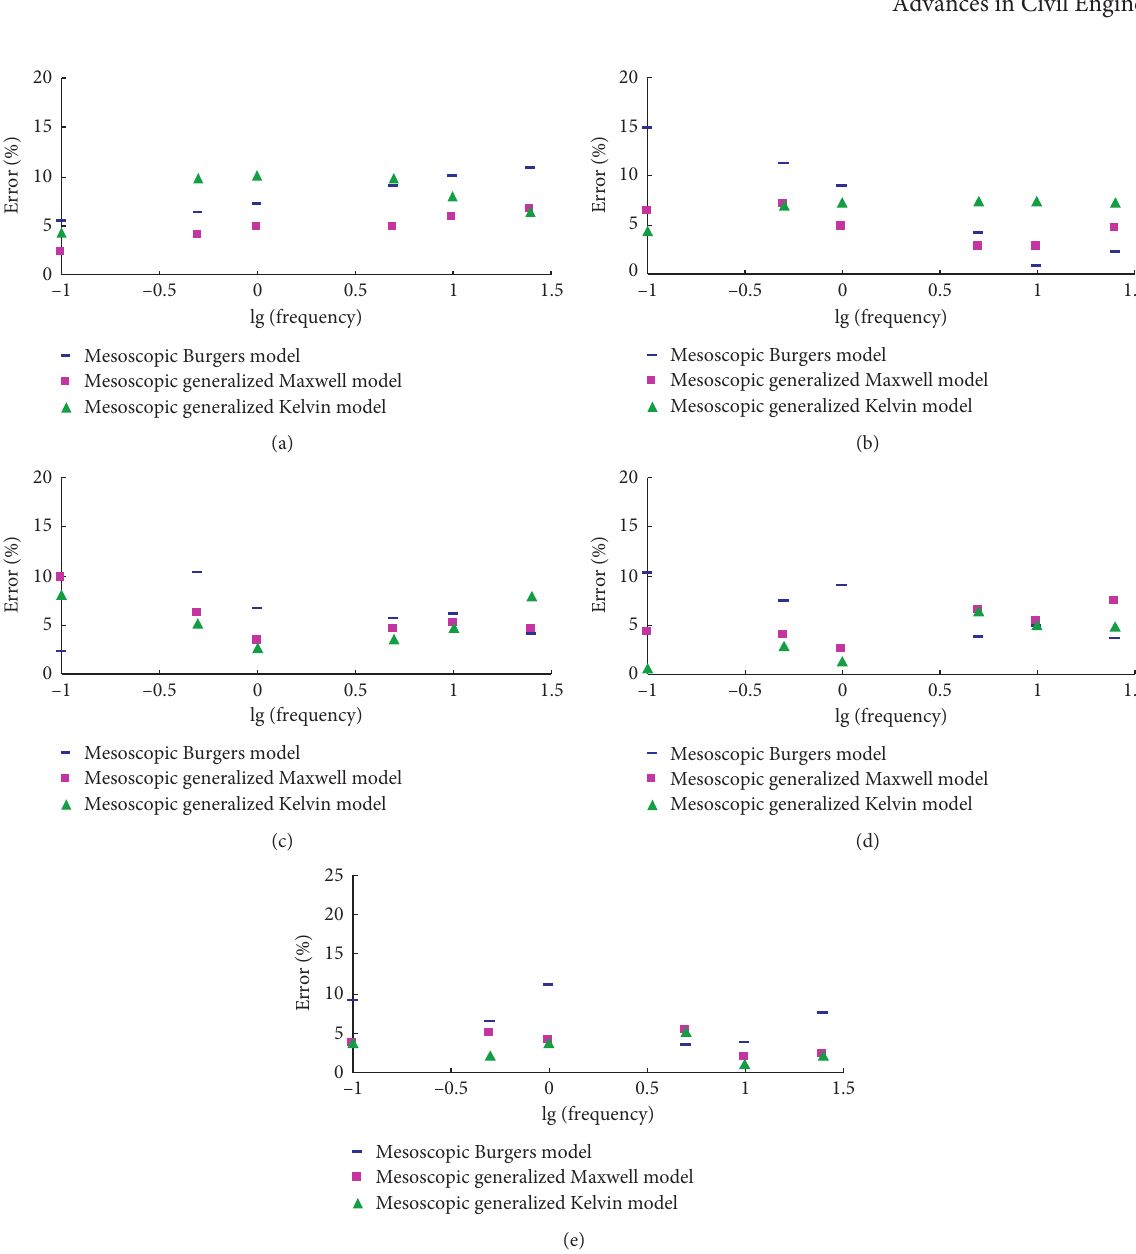
Figure 11: Errors of dynamic modulus. (a) − 6 ° C. (b) 4 ° C. (c) 16 ° C. (d) 27 ° C. (e) 38 °